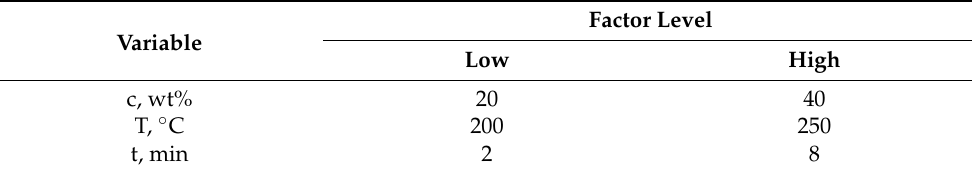
Table 2. Variable factor levels for DOE.